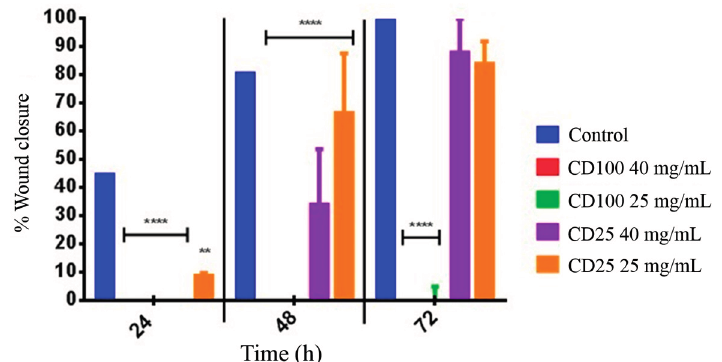
Figure 4. Wound healing assay displaying percentage wound closure of dermal fibroblast cells in an IBIDI insert cell culturing system at 24, 48, and 72 h. HDFa cells were treated with (red) 40 mg·mL − 1 CD-100, (green) 25 mg·mL − 1 CD-100, (purple) 40 mg·mL − 1 CD-25 and (orange) 25 mg·mL − 1 CD-25. Untreated cells served as a control. Data are presented